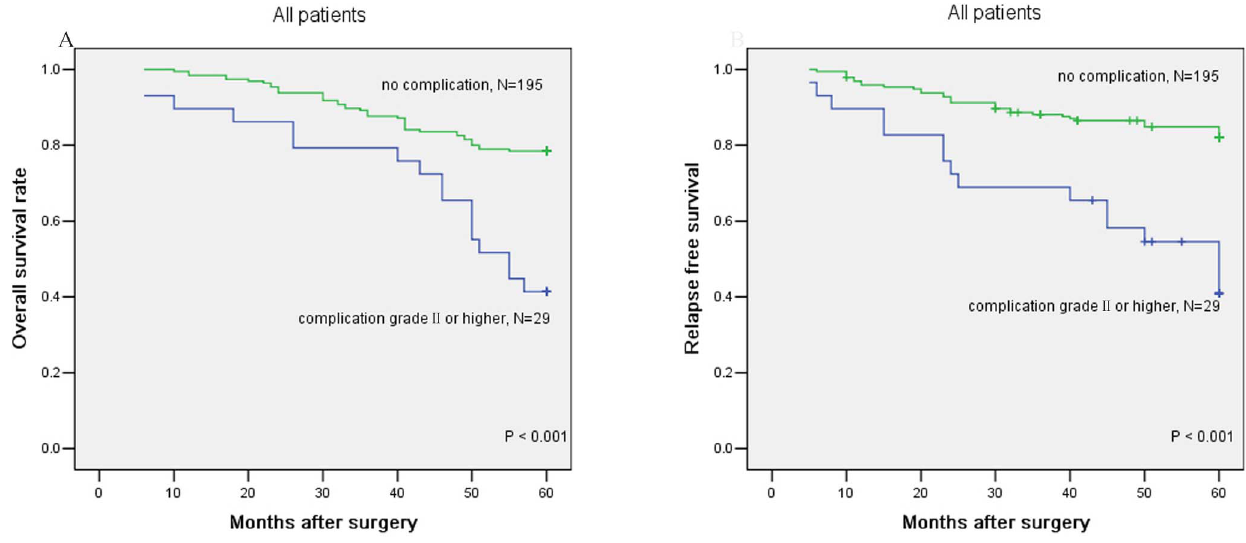
Figure 2. Prognostic significance of complications grade II or higher in the whole population. A: overall survival, B: relapse-free survival. OS and RFS were evaluated using the Kaplan-Meier method and compared with the log-rank test.